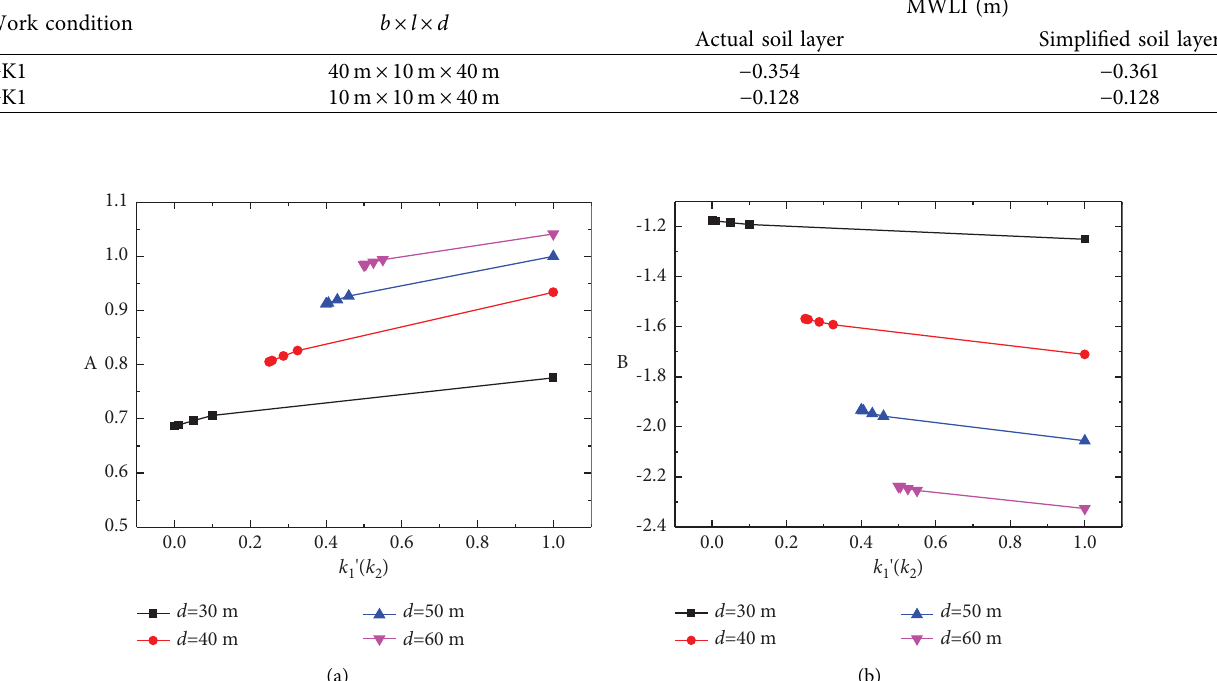
Figure 18: Variation in the coefcients for diferent equivalent hydraulic conductivity ratios. (a) Coefcient A . (b) Coefcient B